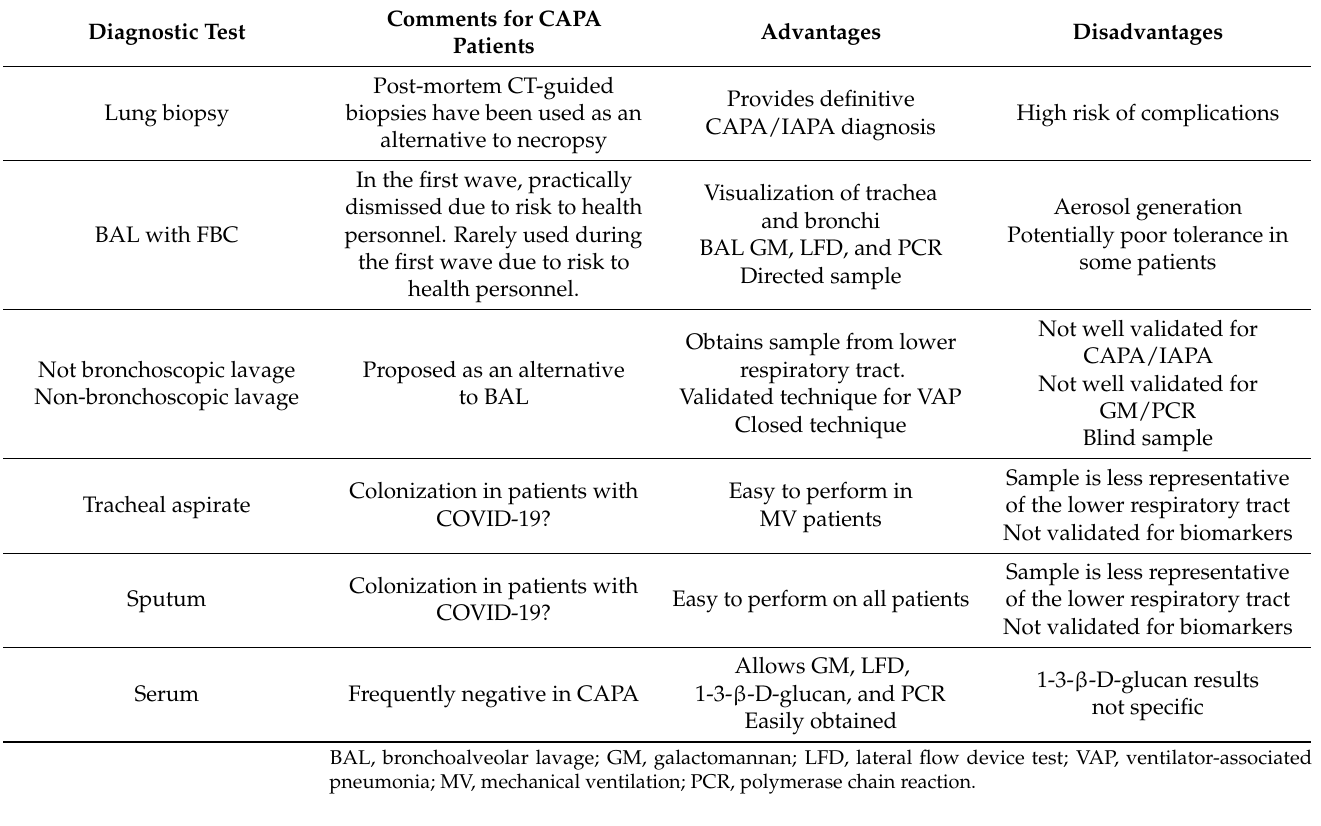
Table 3. Diagnostic Methods Used for the Diagnosis of CAPA/IAPA. Advantages and